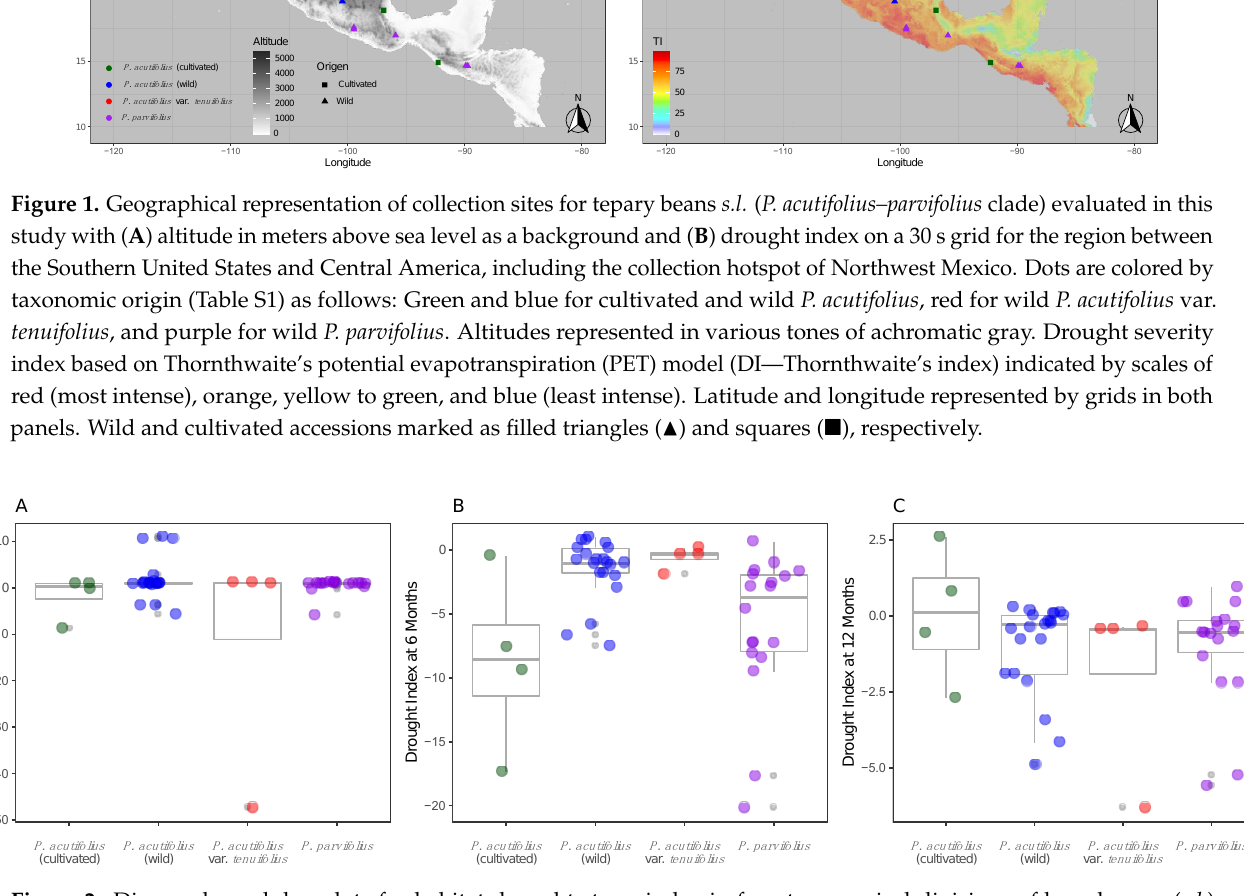
Figure 1. Geographical representation of collection sites for tepary beans s.l. ( P. acutifolius–parvifolius clade) evaluated in this study with ( A ) altitude in meters above sea level as a background and ( B ) drought index on a 30 s grid for the region between the Southern United States and Central America, including the collection hotspot of Northwest Mexico. Dots are colored by taxonomic origin (Table S1) as follows: Green and blue for cultivated and wild P. acutifolius , red for wild P. acutifolius var. tenuifolius , and purple for wild P. parvifolius . Altitudes represented in various tones of achromatic gray. Drought severity index based on Thornthwaite’s potential evapotranspiration (PET) model (DI—Thornthwaite’s index) indicated by scales of red (most intense), orange, yellow to green, and blue (least intense). Latitude and longitude repre- sented by grids in both panels. Wild and cultivated accessions marked as filled triangles ( ▴ ) , respectively.